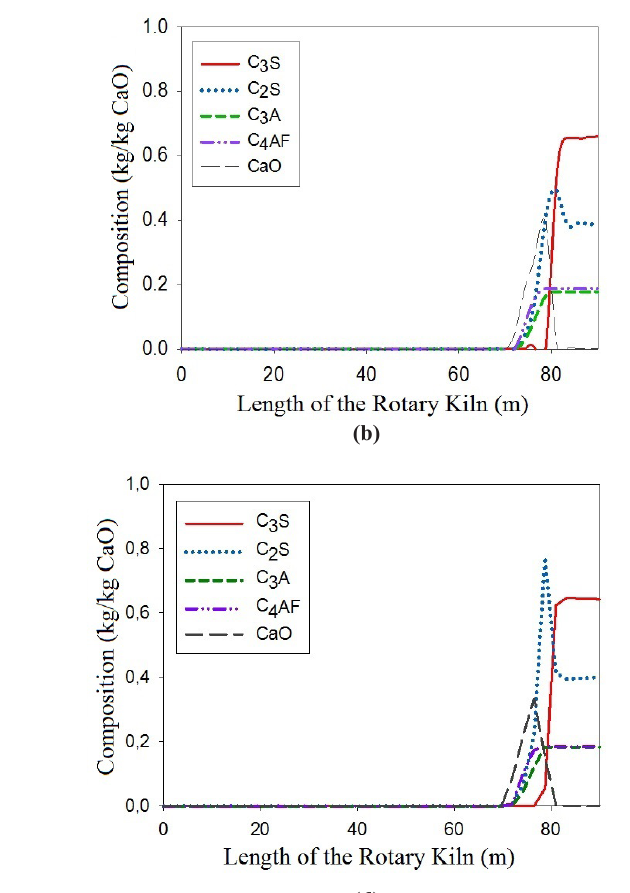
Figure 4 - Concentration profiles of C speed; ( b ) -10% of inlet solid speed; ( c ) +10% of inlet solid speed; ( d ) +20% of inlet solid